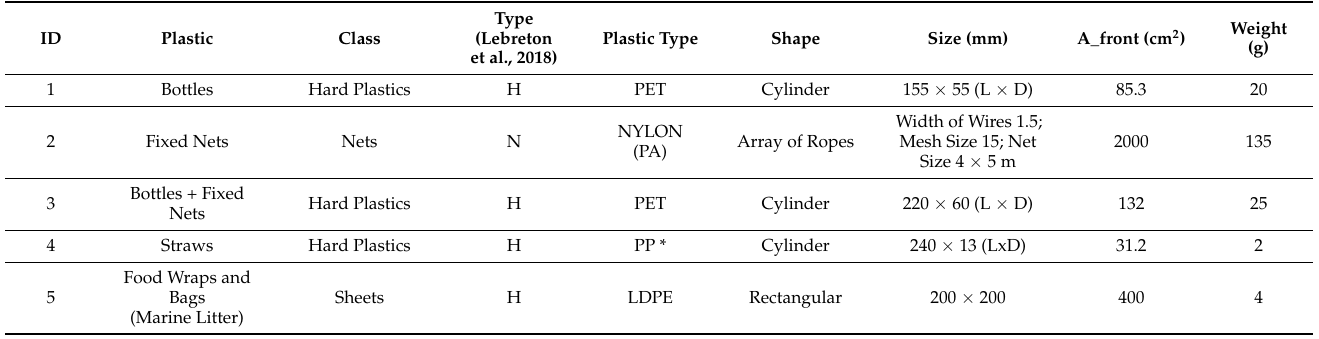
Table A1. Plastics used during the Deltares Test campaigns. Items were classified using the